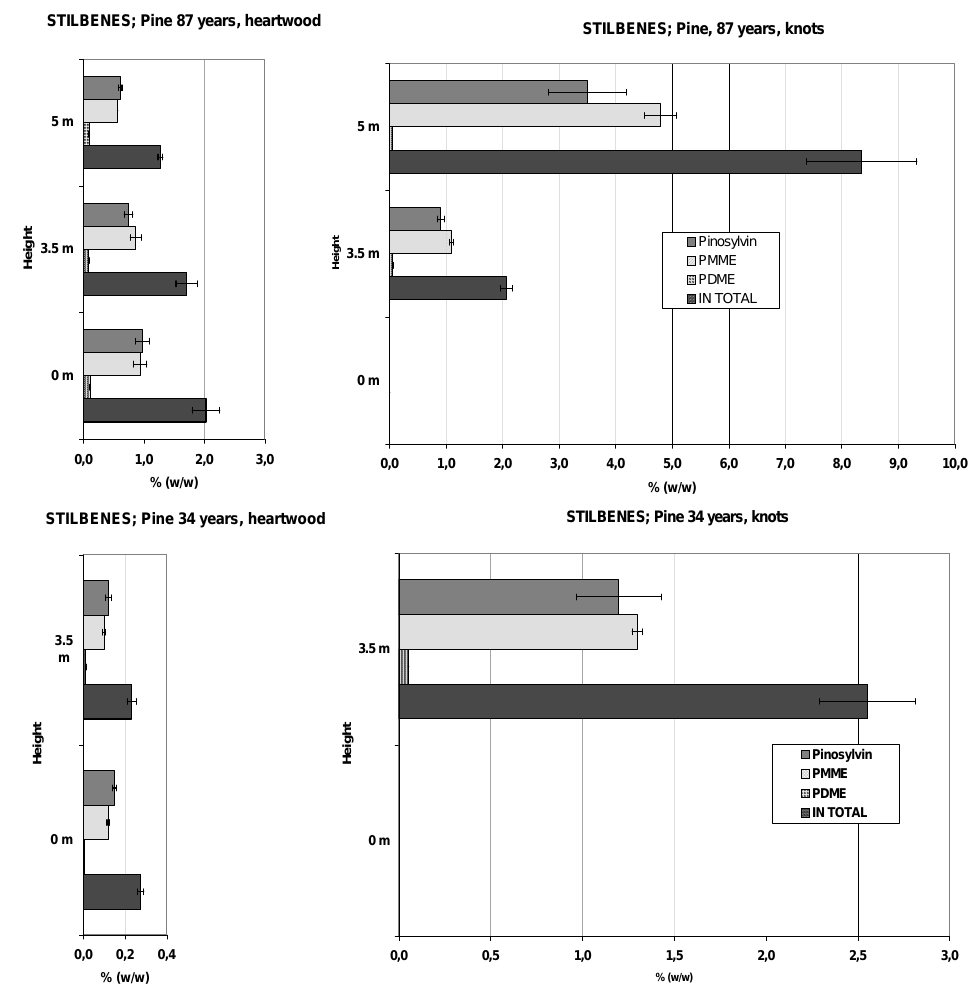
Figure 1 . Stilbene analyses of Norwegian pine and spruce; content (%, w/w) and